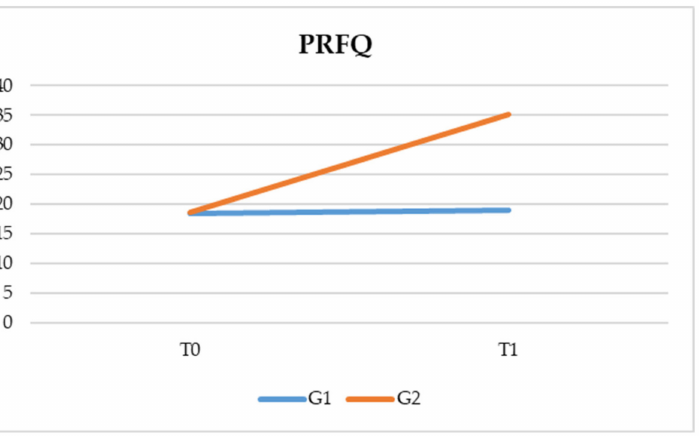
Figure 1. Comparison of the two groups between T0 and T1 at the Parental Reflective Function Questionnaire (PRFQ).